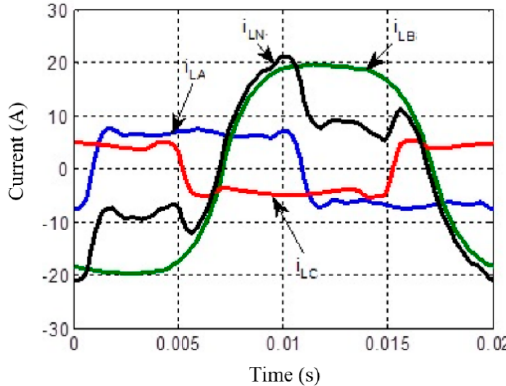
Figure 2. The load phase currents in the most unfavorable case.